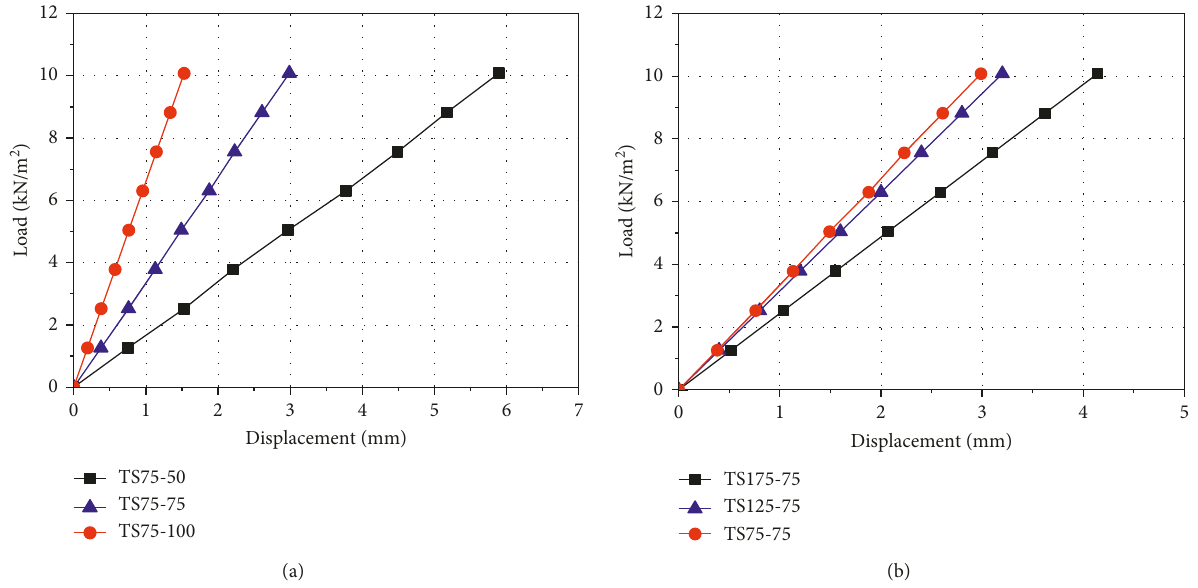
Figure 6: Load-midspan deflection curves of specimens (a) with different web heights and (b) with different web spacing values.